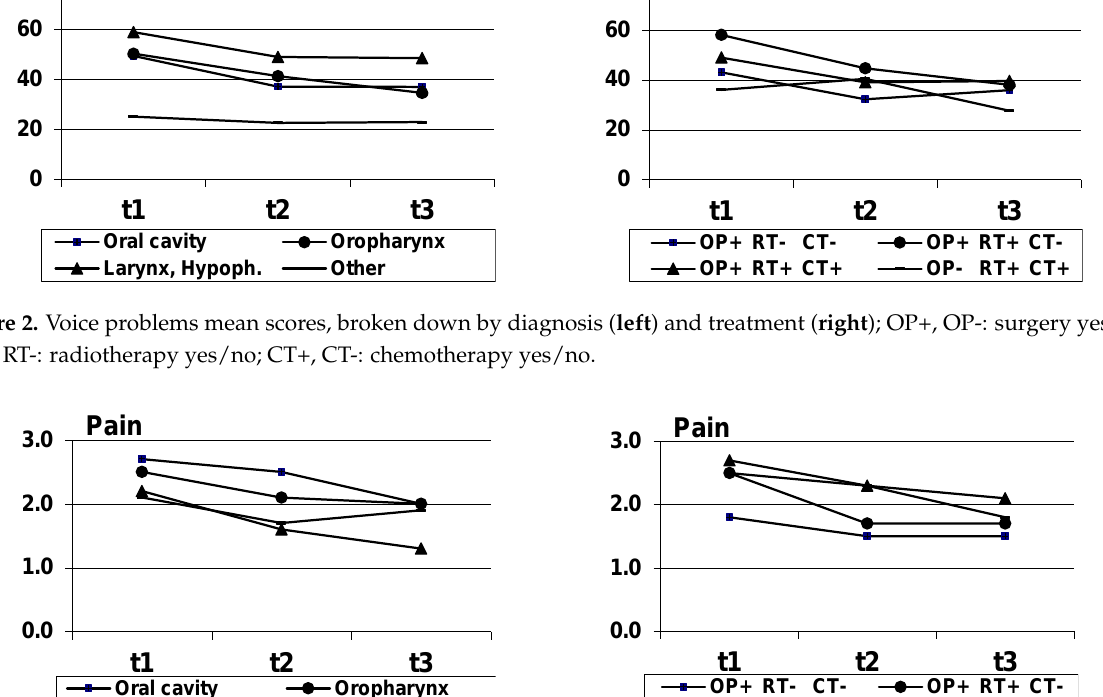
Figure 3. Pain mean scores, broken down by diagnosis ( left ) and treatment ( right ); OP+, OP-: surgery yes/no; RT+, RT-: radiotherapy yes/no; CT+, CT-: chemotherapy yes/no.